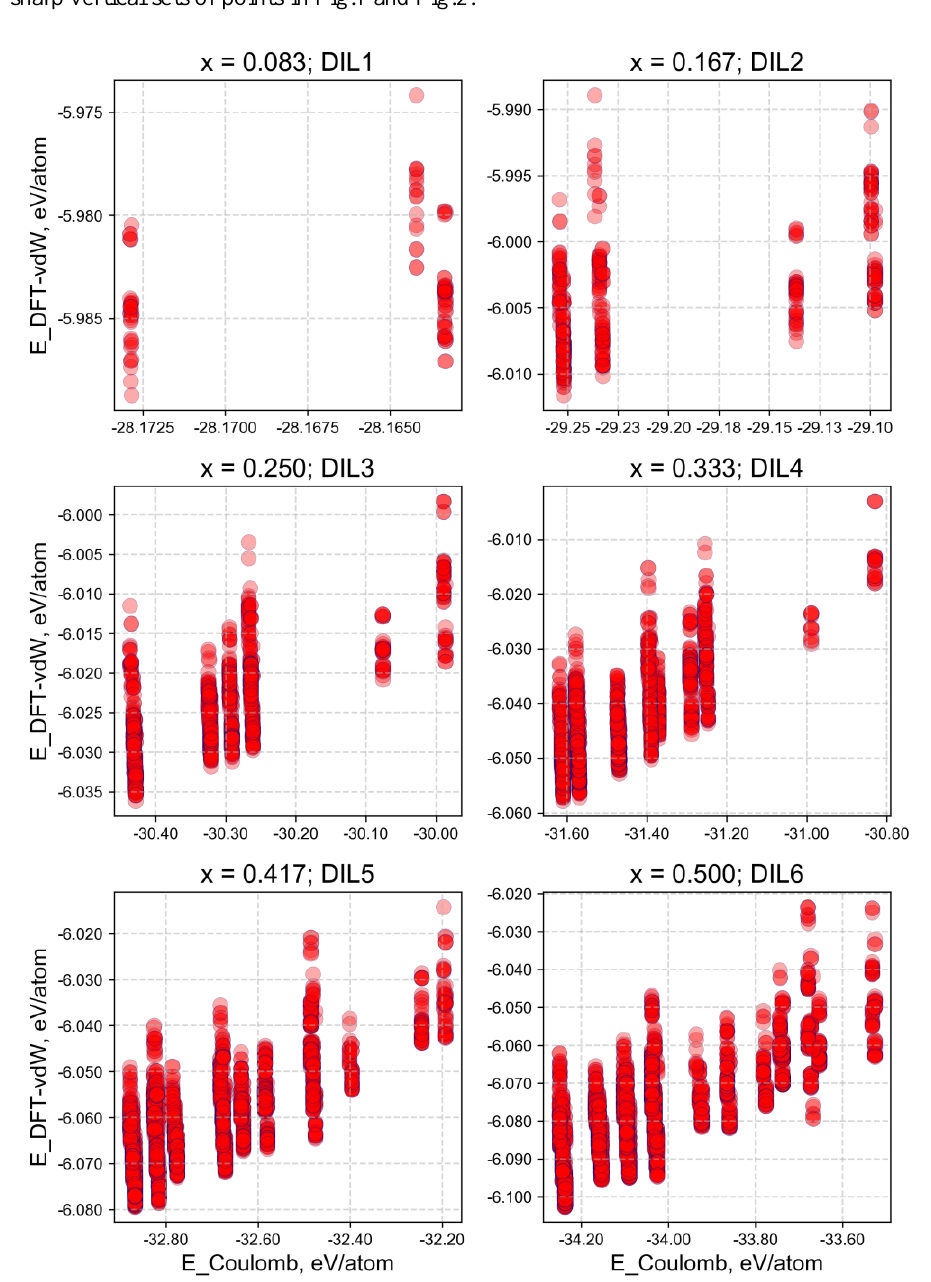
Fig. 1 . Comparison of the DFT-vdW ( E_DFT-vdW ) and Coulomb ( E_Coulomb ) energies for the NCA CCS subset corresponding to low and medium-low DILs: Li 1-х Ni 0.8 Co 0.15 Al 0.05 O 2 , where 0 < x ≤0.5 .